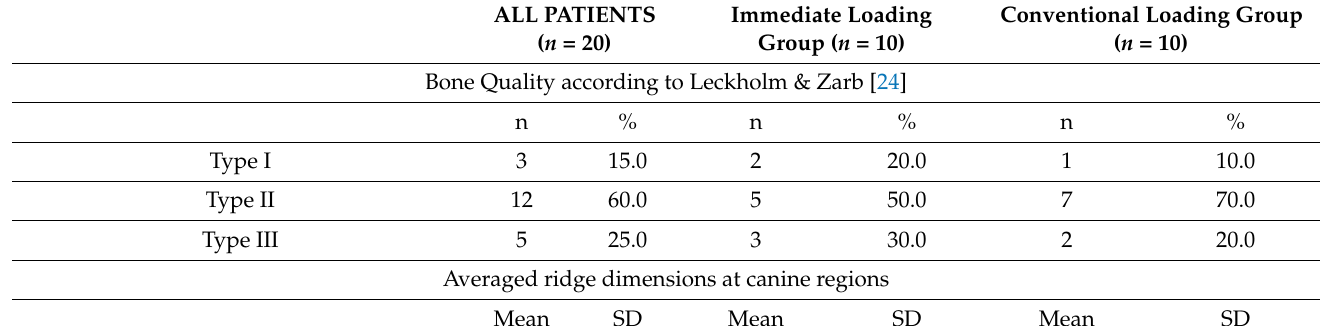
Table 3. Anatomical baseline conditions of the jaws at the implant sites ( n = 20), and distribution of the implant sizes. Comparisons by Chi-square and Student t